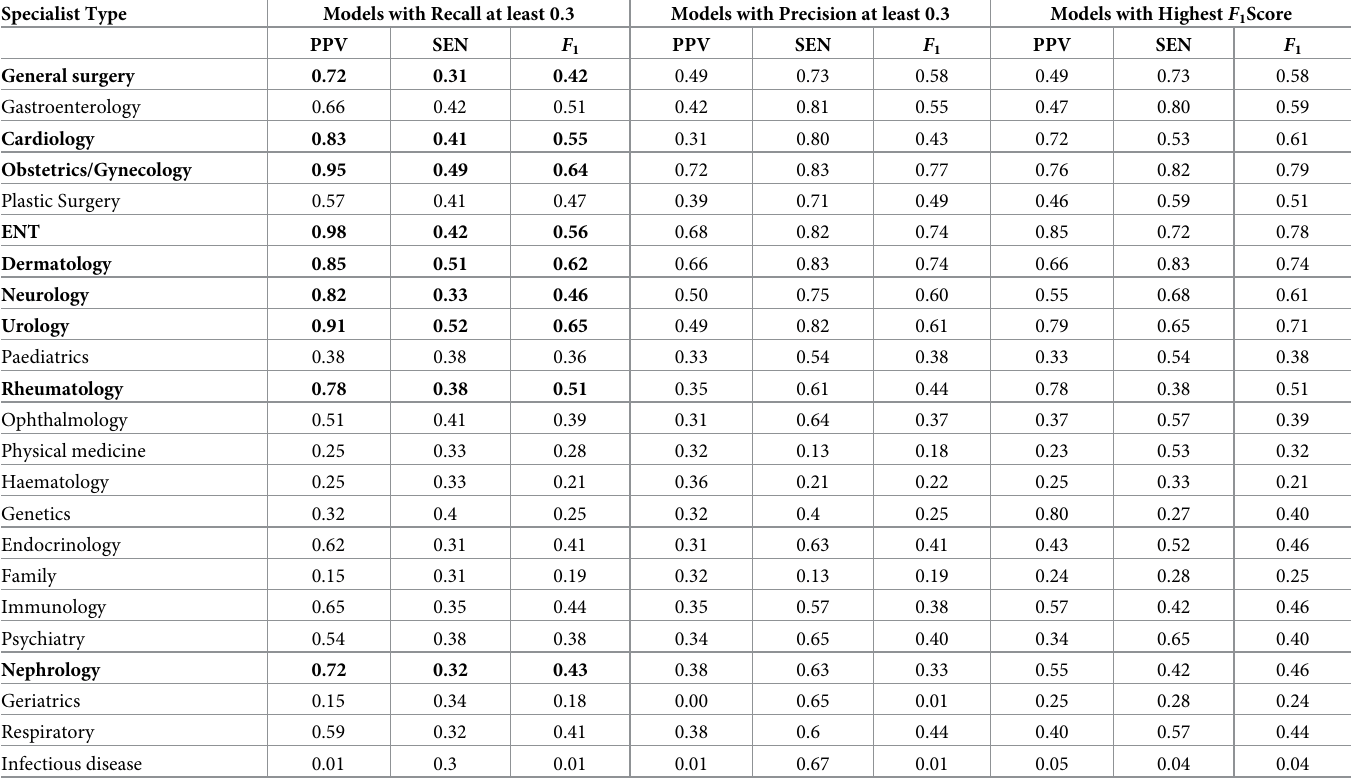
Table 3. Precision, recall, and F 1 Score for each optimization for each specialty found in Table 1. We do not present evaluate any models for the “aesthesia” class as there were fewer examples than folds. Specialties which are bolded pass our performance threshold. Specialist Type Models with Recall at least 0.3 Models with Precision at least